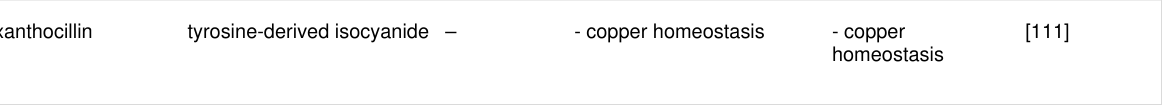
Table 1: Overview of Aspergillus fumigatus secondary metabolites and their roles during virulence and in their ecological context. (continued) xanthocillin